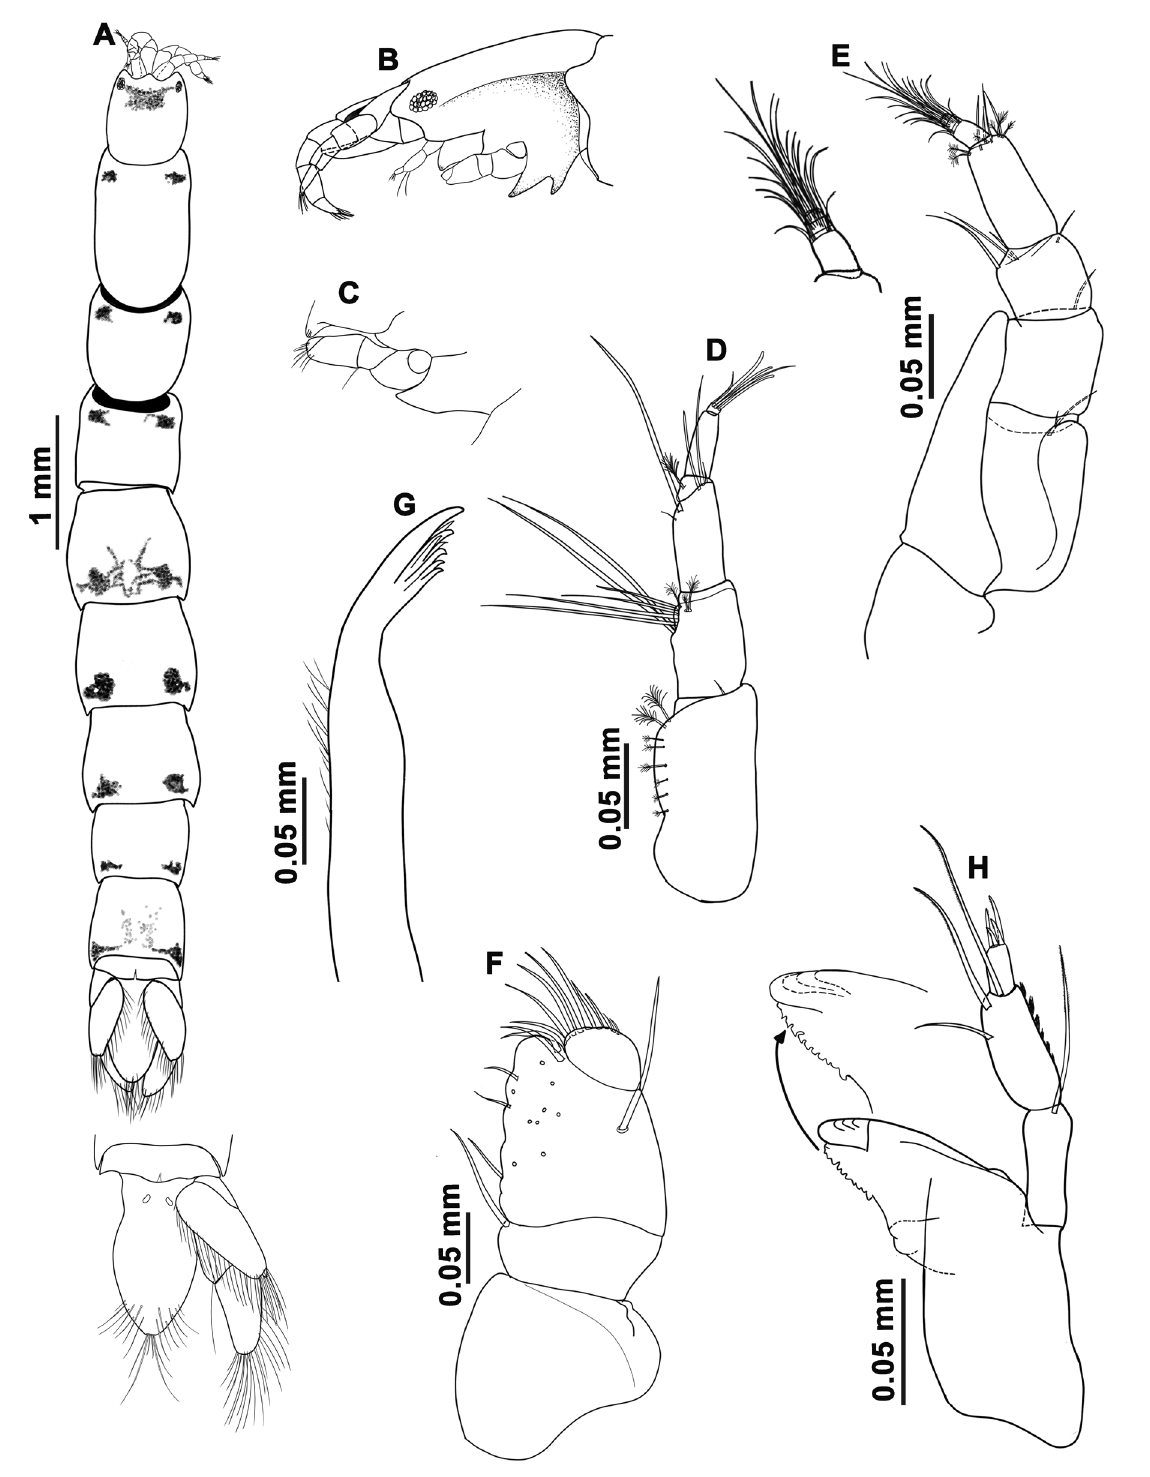
Fig. 14. Skuphonura oaxaquensis sp. nov. A–B, D–H . Holotype, ♀, 7.9 mm, Oaxaca, Puerto Ángel, Estacahuite Beach (UMAR-PERA 548). A . Habitus and detail of the pleotelson. B . Cephalon. C . Paratype, ♂, 7.3 mm (UMAR-PERA 549). Base of mouthparts. D . Antennule. E . Antenna and detail of flagellum. F . Maxilliped. G . Maxilla. H . Mandible and detail of the